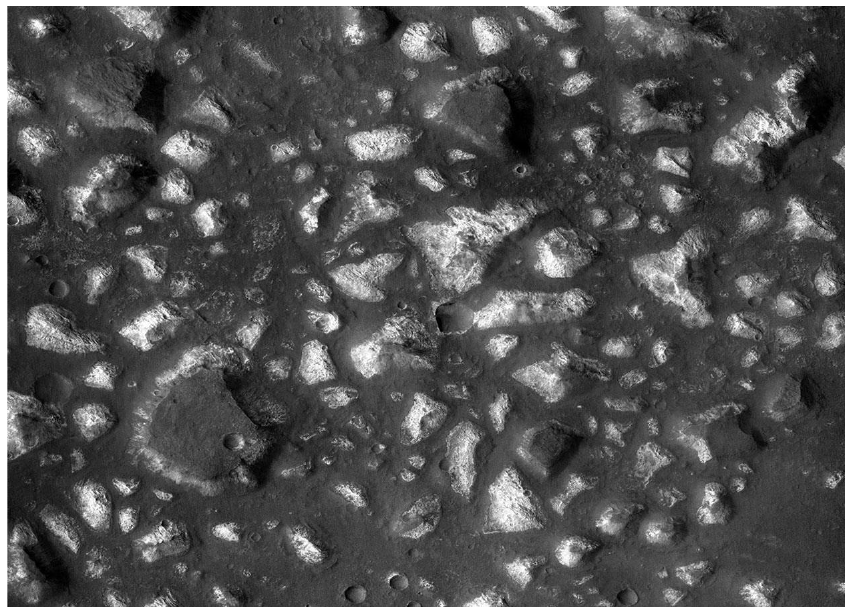
Figure 5. Deep-basin deposits from the floor of the Eridania Sea. The mesas on the floor are there because they were protected against intense erosion by deep water/ice cover. CRISM measurements show minerals may be from seafloor hydrothermal deposits.